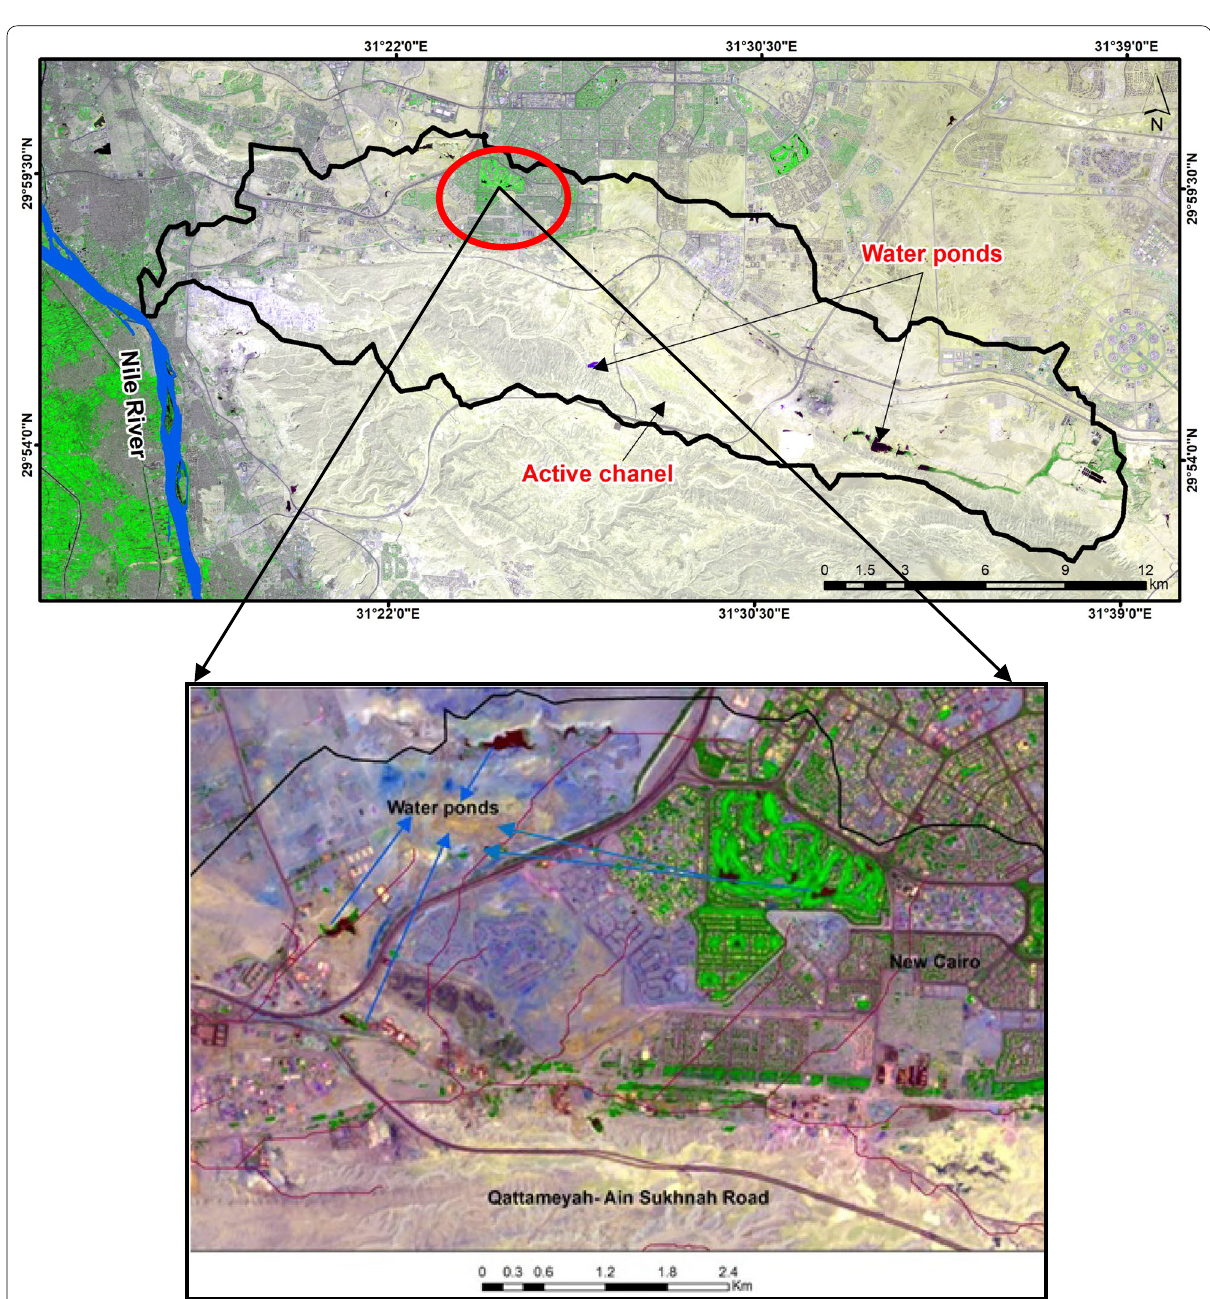
Fig. 10 Landsat 8 satellite image showing the problems of water ponding and water logging within Wadi